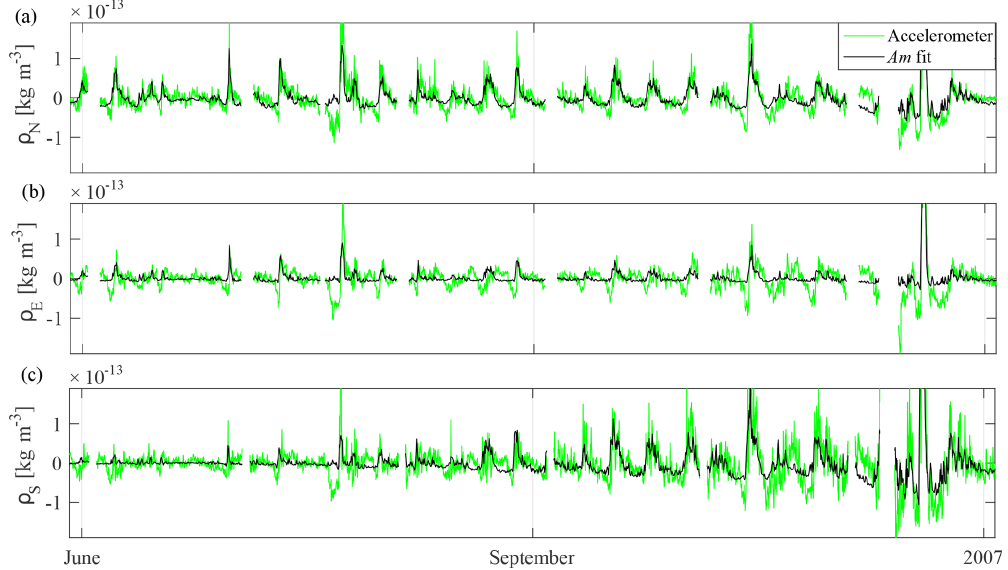
Figure 6. Thermospheric mass density disturbances ( δ <10d) due to magnetospheric forcing at an altitude of 475km, and the parameter- ization in terms of the Am index, which is dependent on solar cycle and seasonal variation. From top to bottom, northern, equatorial, and southern profiles are presented. Only June to December in 2006 is presented from the full time series.